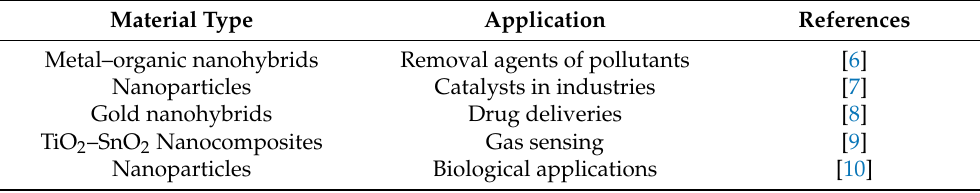
Table 1. Applications of different types of nanomaterials and